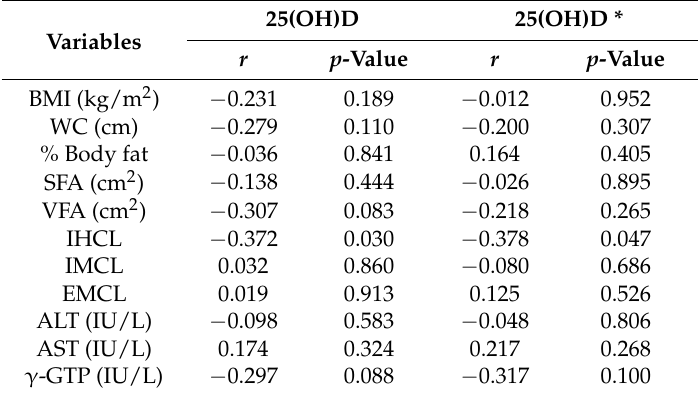
Table 2. Correlations between 25(OH)D concentrations and other